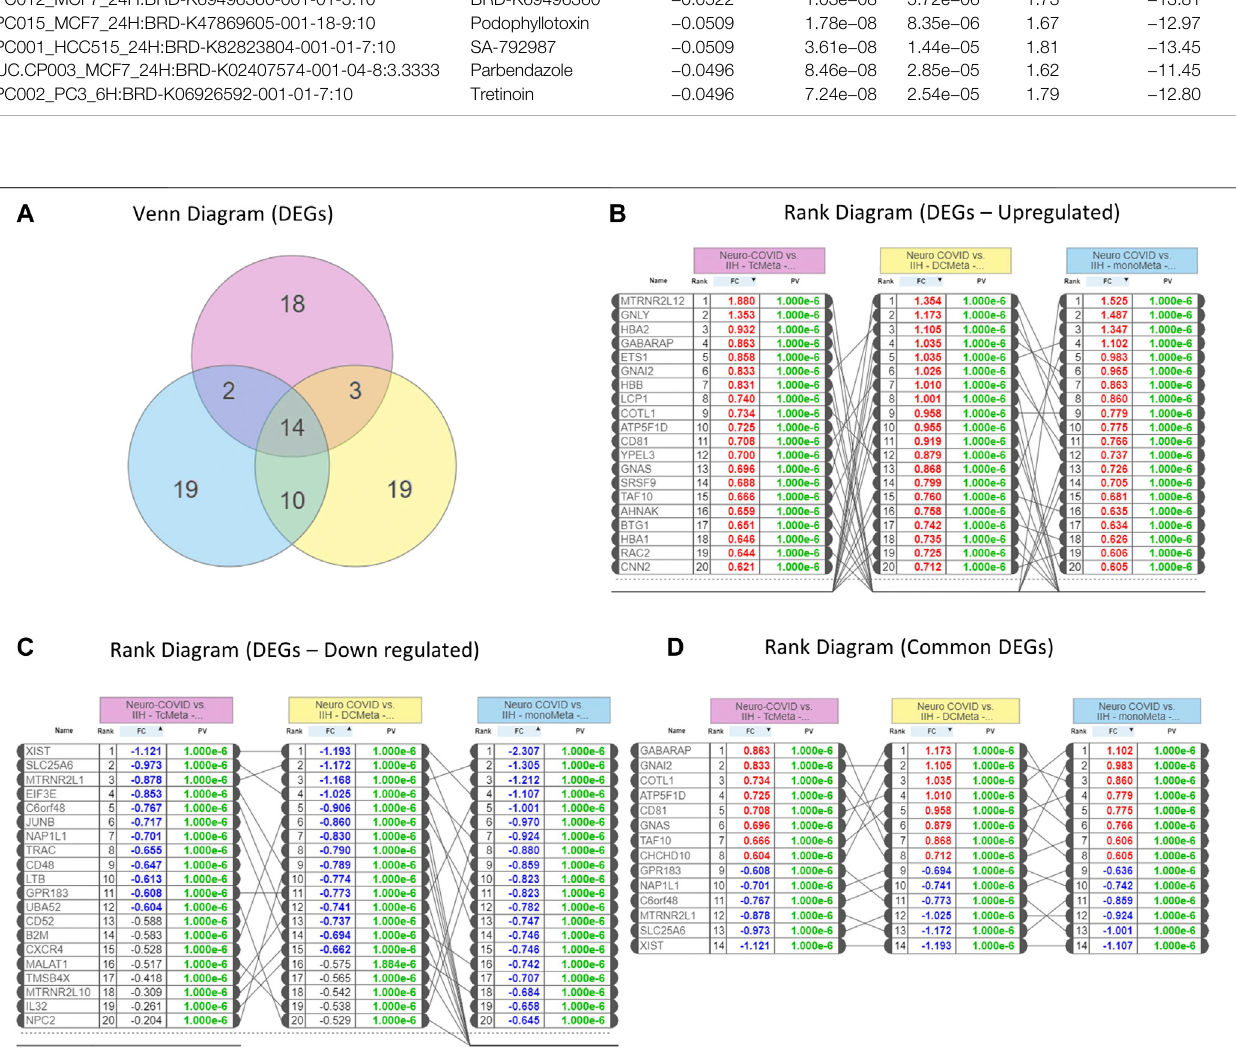
Frontiers in Pharmacology |